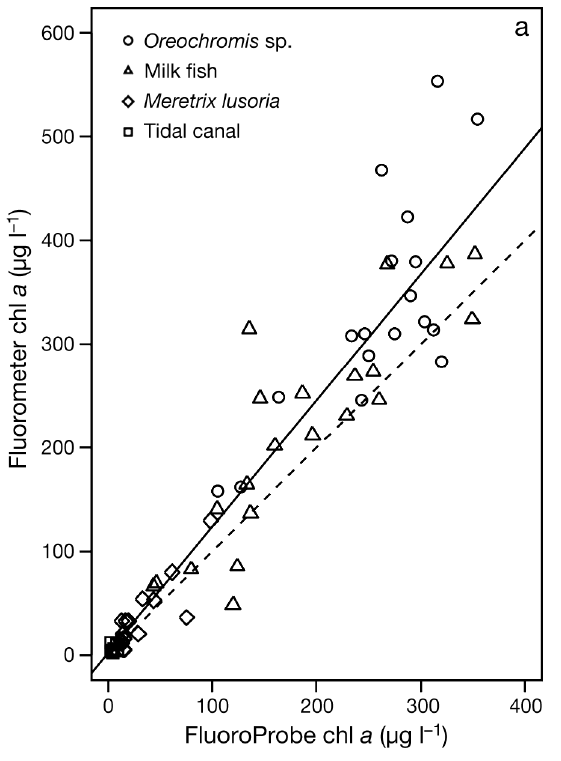
Fig. 2. Relationships between chlorophyll a (chl a ) measured by the FluoroProbe and: (a) chl a measured by the fluoro - meter, (b) algal density, and (c) algal biovolumes. Solid lines are regression lines; dashed line shows a 1:1